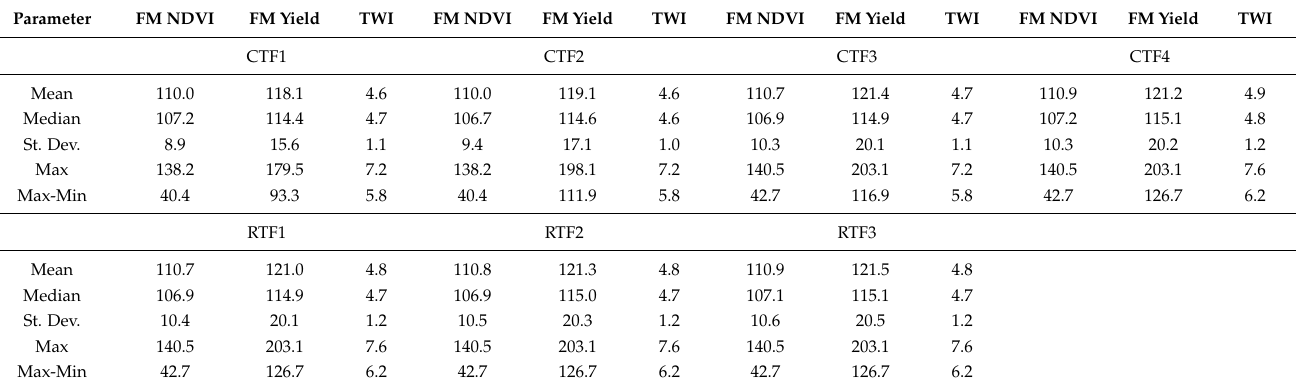
Table 4. Summary statistics of resulting frequency maps (FM) for NDVI, yield and topography wetness index (TWI) and individual types of management system: controlled traffic farming (CTF) and random traffic farming